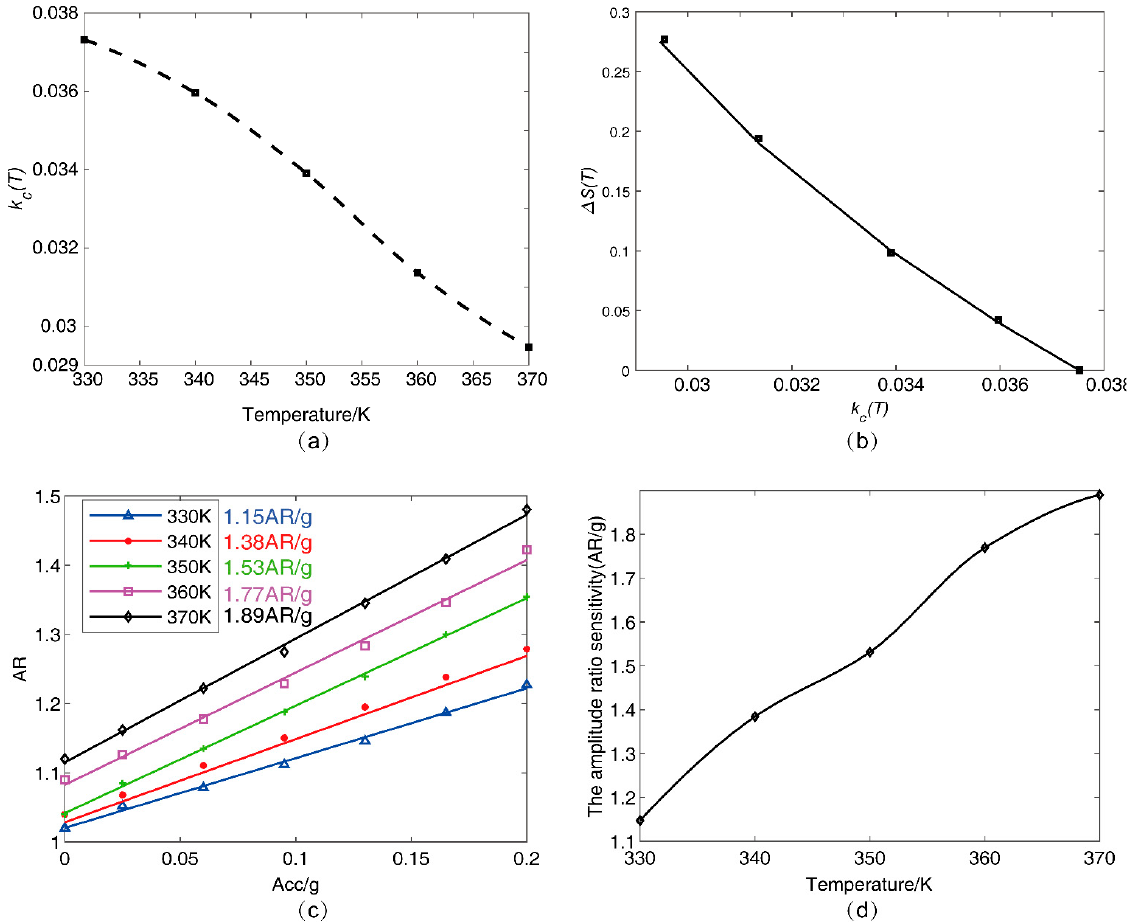
Figure 13. ( a ) The experimental results of the coupling stiffness k c versus temperature T , and ( b ) the experimental results of the normalized drift of the parameter sensitivity in AR with variation of the coupling stiffness with temperature ranges from 330 K to 370 K; ( c ) the amplitude ratio of the mode-localized accelerometer at different temperatures ranging from 330 K to 370 K in 10 K steps; ( d ) temperature coefficient of accelerometer output amplitude ratio range from 0 g to 0.21 g.